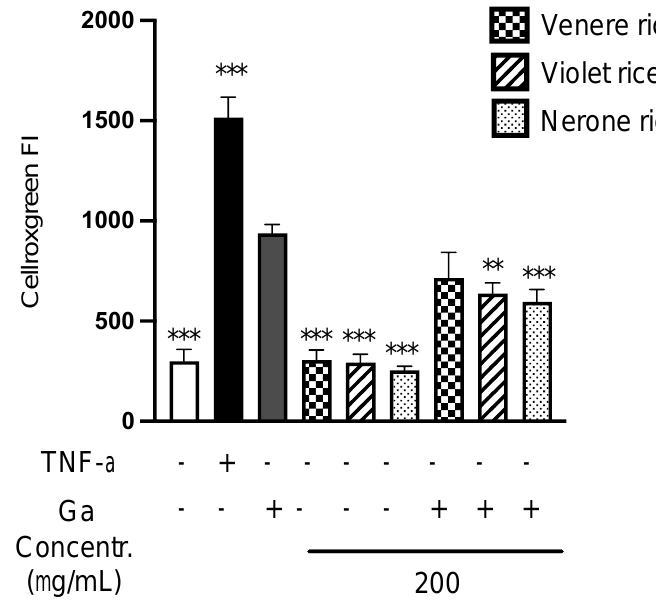
Figure 8. Intracellular reactive oxygen species (ROS) levels in Caco-2 cells, measured as the fluores- cence intensity (FI) of Cellrox Green. Caco-2 cells were treated for 24 h with 500 μg /mL digested gliadin (Ga) or rice extracts (200 μg/mL) . A set of samples were exposed to rice extracts 3 h before exposure to Ga. Levels of ROS in the untreated cells (white bar, Control − ) and in cells treated only with TNF- α 40 ng/mL (black bar, Control +) were also reported. Data are the means (± SD) of three replicates analyzed in duplicate. ** p < 0.01, *** p < 0.001 vs. Ga stimulus 500 μg/mL .